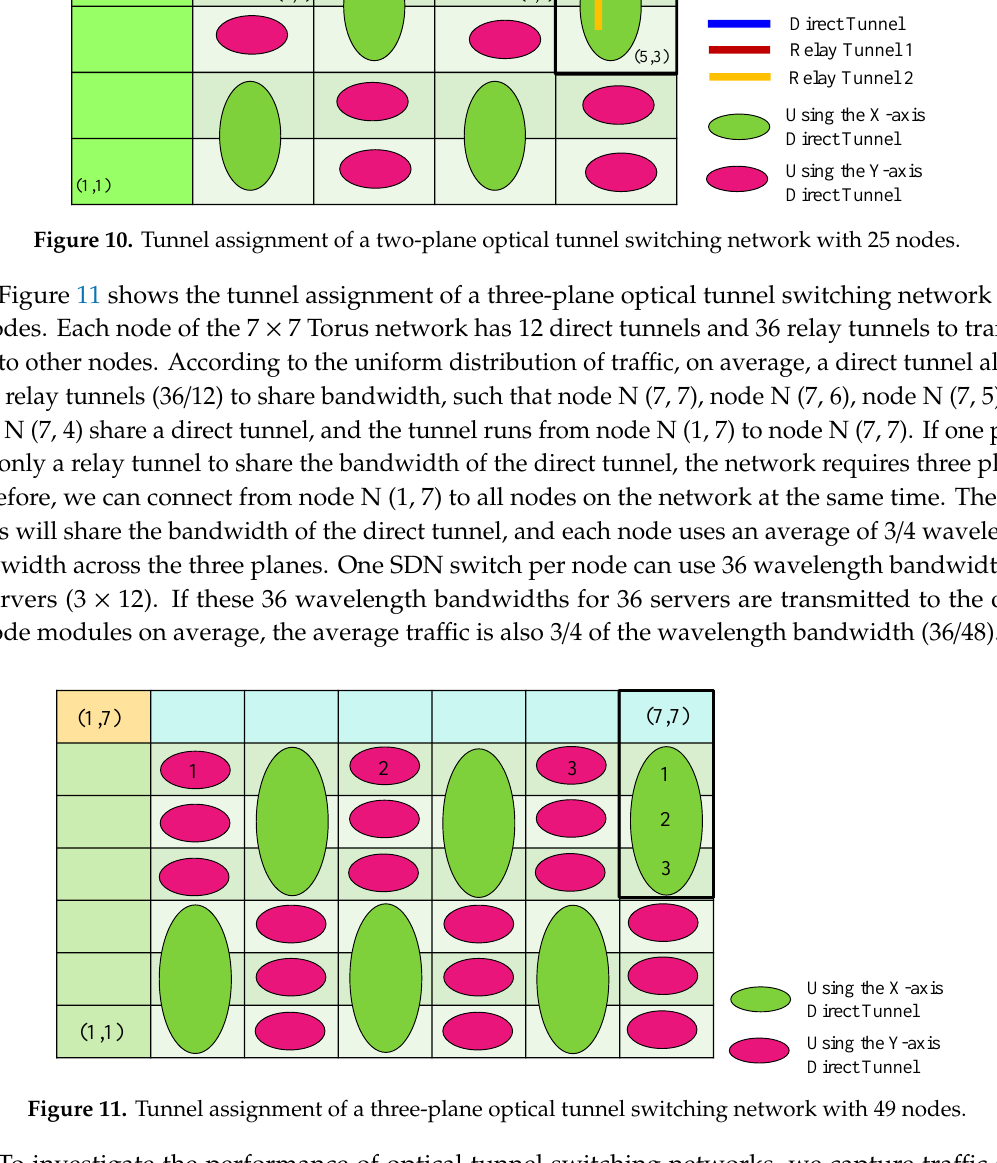
Using the Y-axis Direct Tunnel